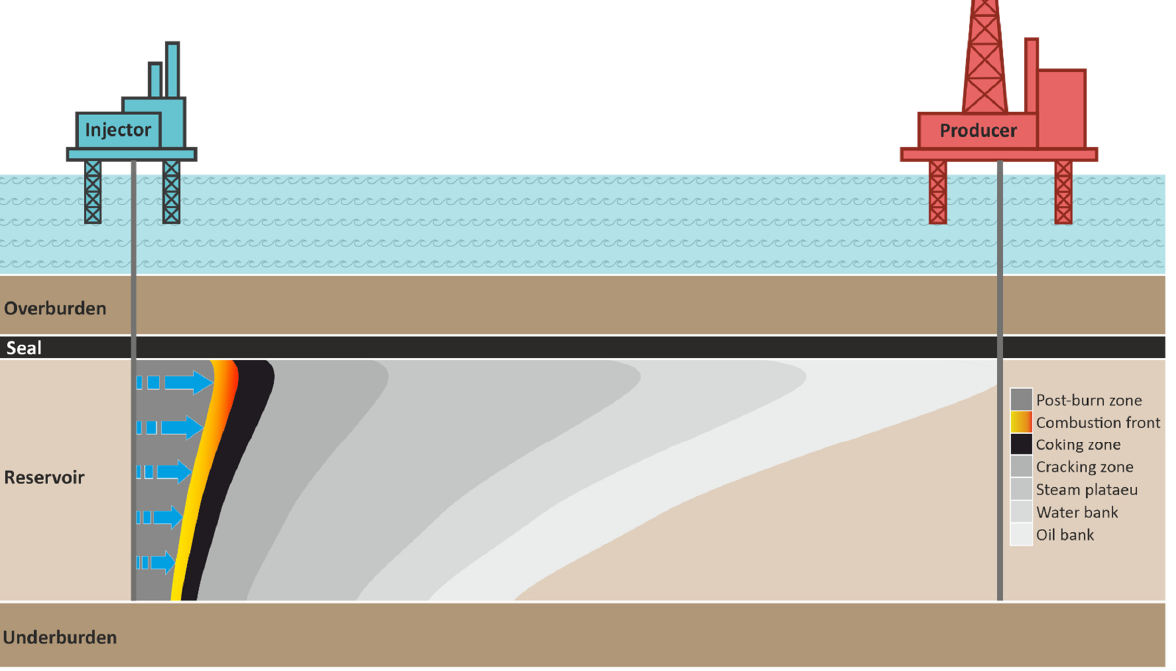
Figure 1. Schematic diagram of the in-situ combustion process in an oil reservoir, showing the different zones from left to right; burned zone, combustion front, coking zone, cracking zone, steam plateau, water bank, oil bank, and undisturbed reservoir, adapted from [2,9].